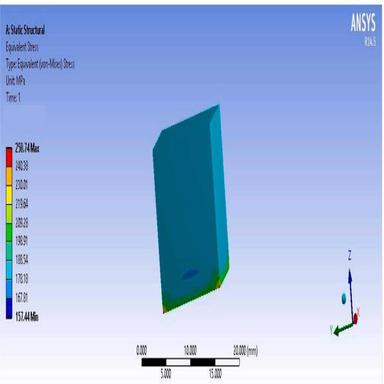
Equivalent stress distribution of Citrus limetta peel powder composites on compression specimen.